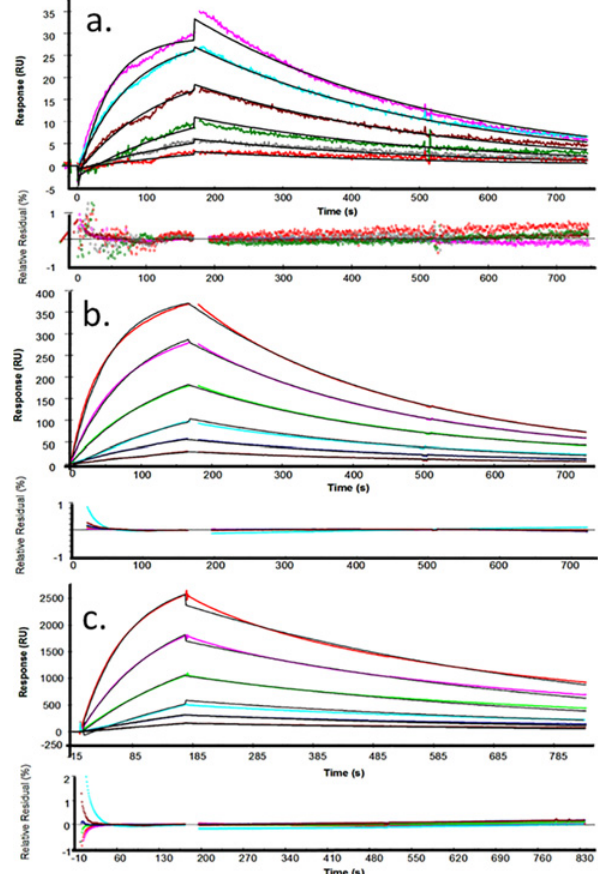
Fig 2. Kinetic measurements on surfaces with different ligand densities. Six concentrations of scFv (2-fold dilutions from 24 to 0.75 nM) were injected at 25°C. The responses from the in-line reference flow cell and blank injections were subtracted from all curves. The curves were globally fitted to a 1:1 Langmuir binding model. For each surface density, the experimental sensorgrams (coloured lines) were overlain with the theoretical fitted curves (black lines). In each case, the relative residual plots show the difference between the experimental and the theoretical curves expressed as a percentage of the observed response for each analyte concentration. The spikes observed at the beginning and the end of analyte injections are the result of in-line reference subtraction with the slight sensorgran misalignment introduced with sequential analyte flow in the multichannel mode. Nevertheless, residuals are mostly within 1% of R obs . The surface density, expressed as the maximum analyte binding capacity (Rmax) was determined experimentally: Rmax (cid:1) 49 RU (a); 465 RU (b); 3100 RU